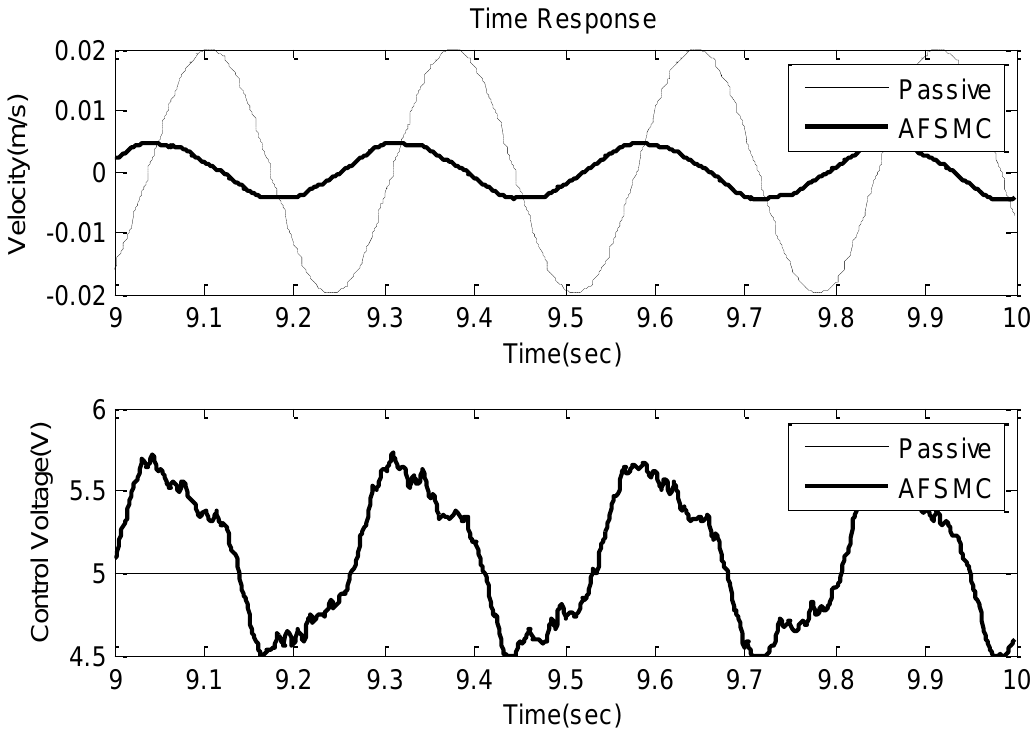
Figure 6. Time domain velocity response (upper) and control voltage (lower) of the passive and AFSMC-active isolator under sinusoidal disturbance (9–10